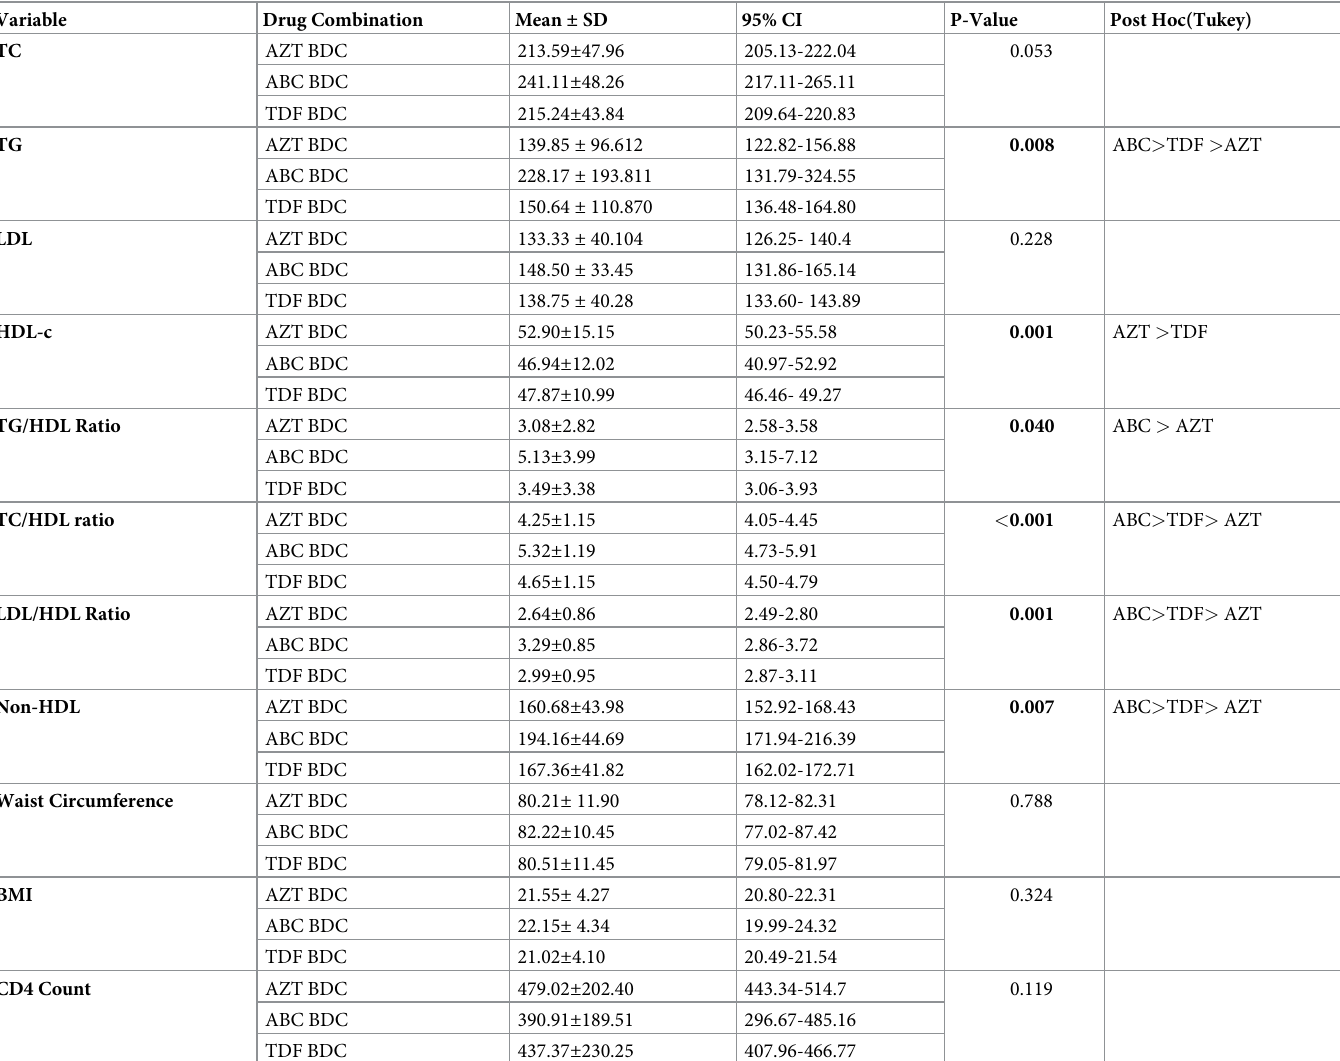
Table 4. Mean and SD of the lipid profile among three HAART drug combinations.